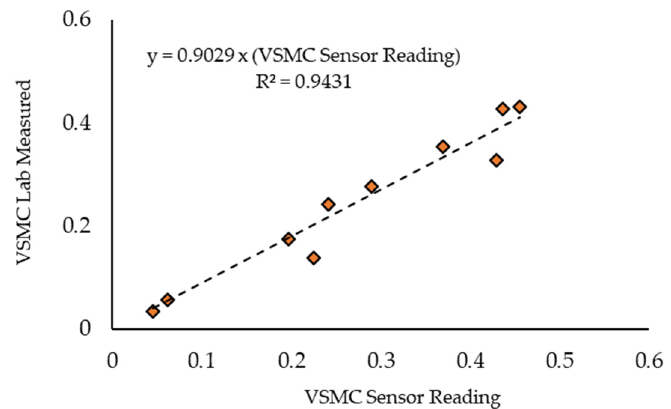
Figure 5. Validation of VSMC Lab measured versus sensor reading.